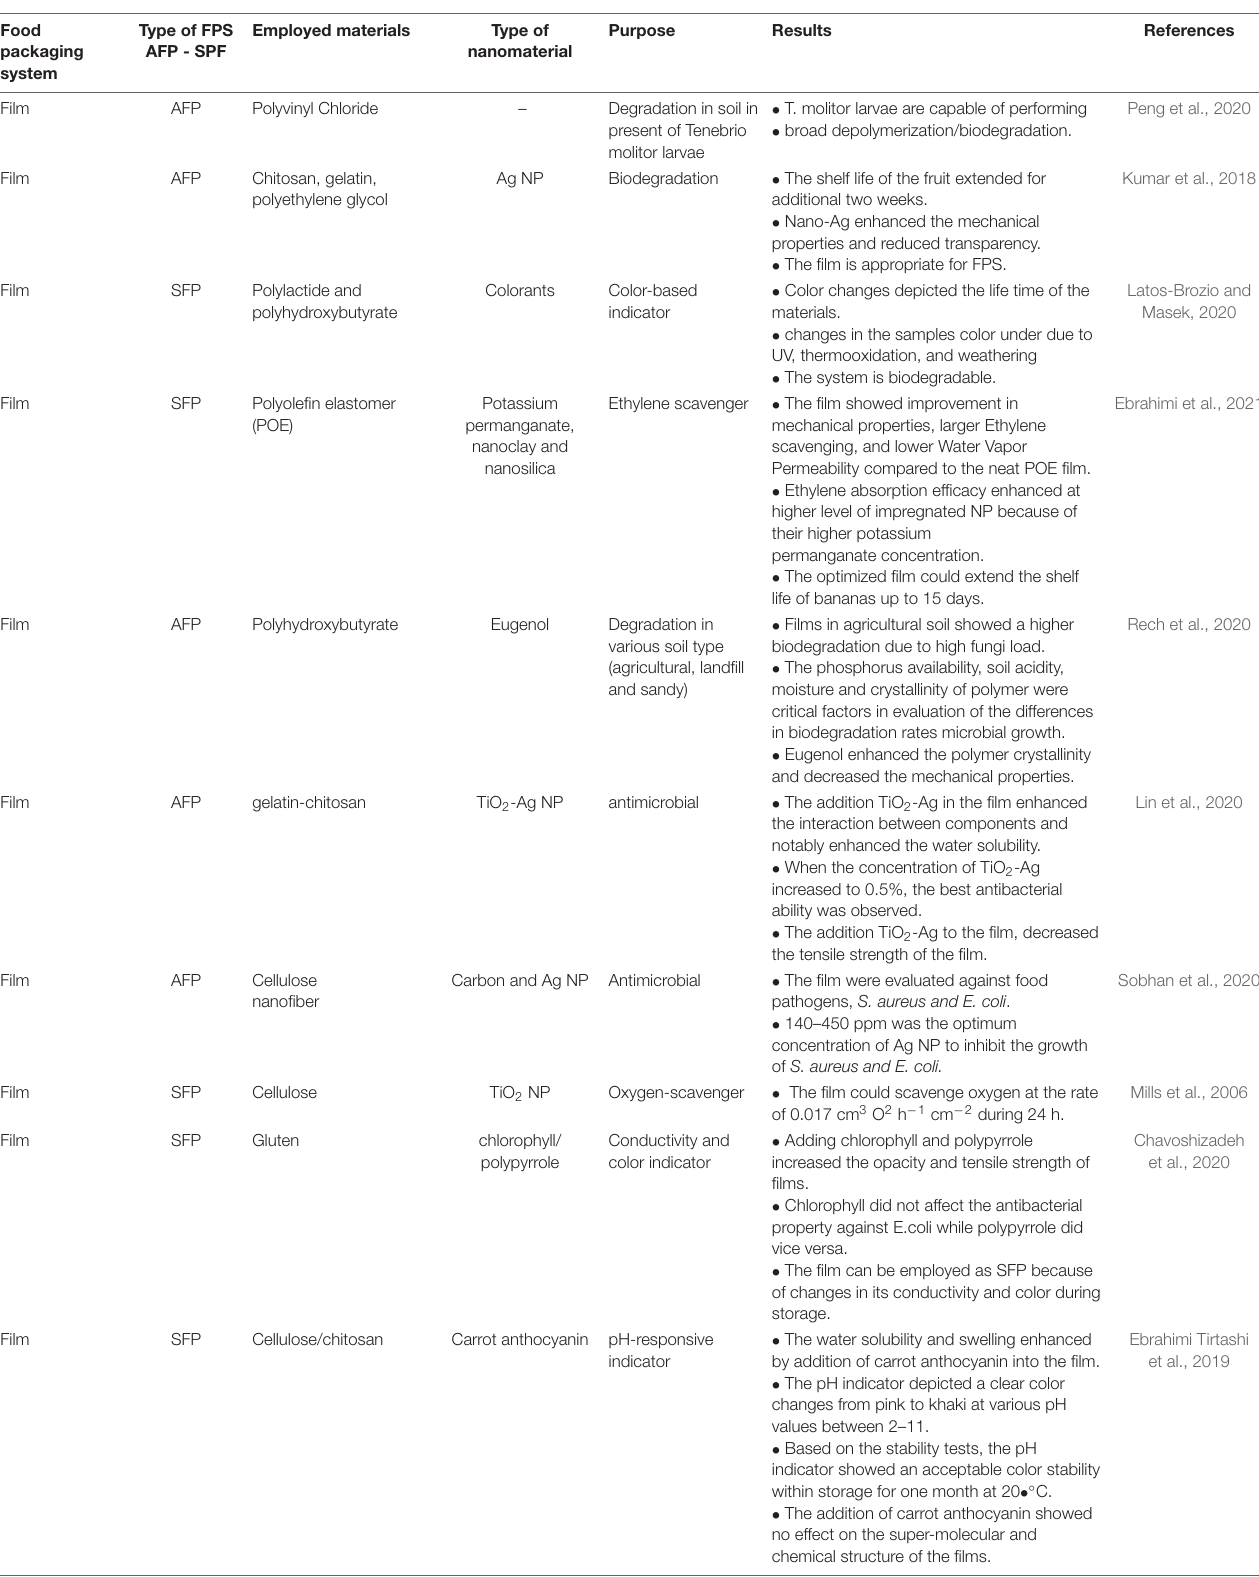
TABLE 1 | a short description of some NFP systems. Food